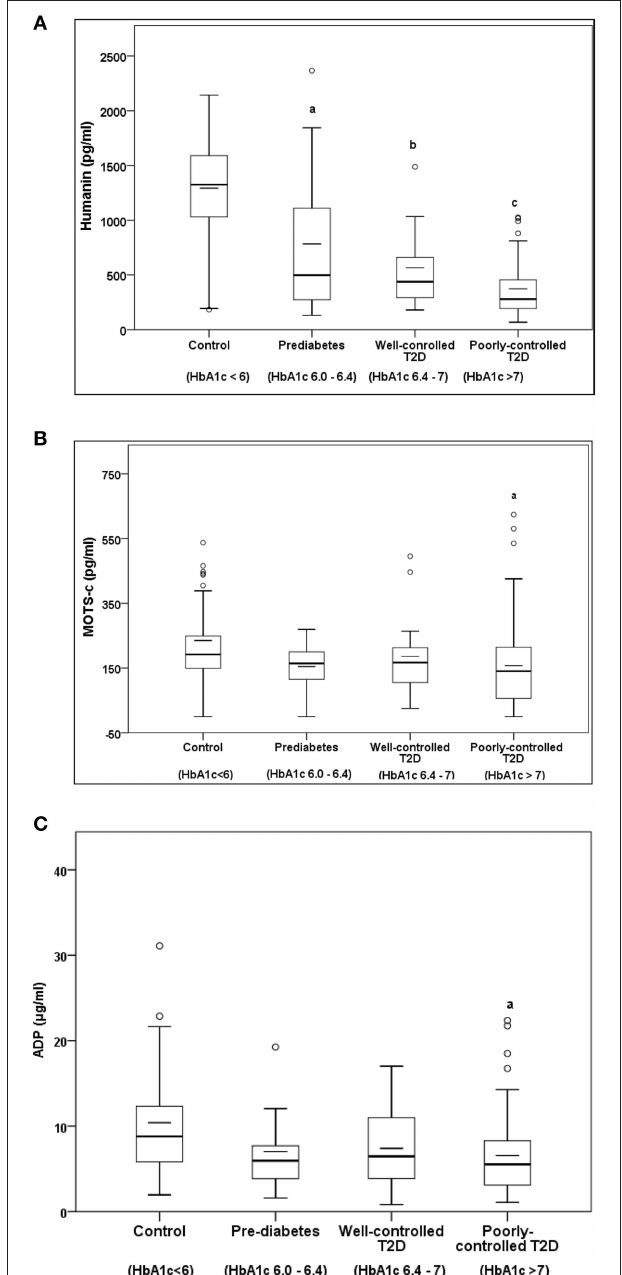
FIGURE 1 | The Boxplot of (A) HN, (B) MOTS-c, and (C) ADP concentration in circulation and its association with variation of HbA1C in control, prediabetes, well-controlled T2D and poorly-controlled T2D subjects. Lower border of the box plots represent the 25th percentile and the upper border represents the 75th percentile ± SD. Short–inside the Boxplot represents statistical mean for HN (A) , MOTS-c (B) , and ADP (C) , respectively. Alphabets on the Boxplot represent significant difference between groups. (a) P < 0.0001 between control and prediabetes, (b) p < 0.0001 between control and T2D good control, and (c) p < 0.0001 between control and T2D poor control. Out layers are highlighted as circles.